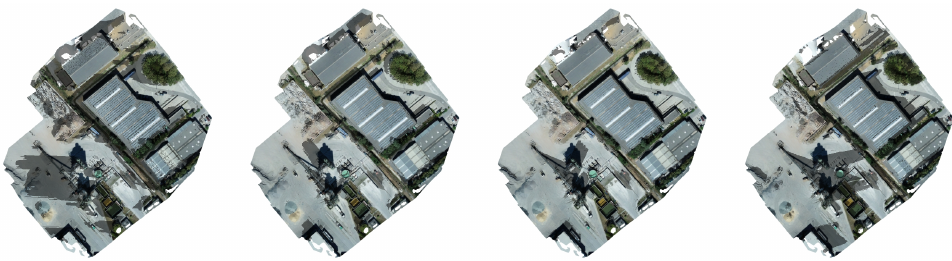
Figure 4. Shadow maps generated for a Belgian PV site for 7 August at times 7:00 AM, 10:00 AM, 1:00 PM and 4:00 PM. By modelling the shading profile during the entire year, we can compare the expected power output with the true output of the respective solar array or string. A discrepancy between both values may indicate that a defect is occurring or that the string or panel array is suffering from